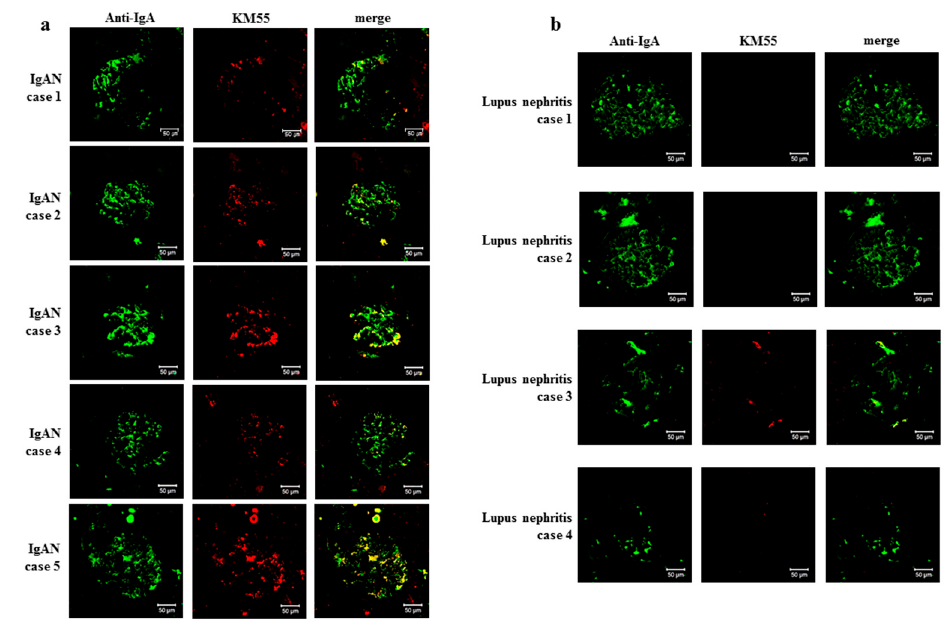
Figure 4. KM55 mAb staining. ( a ) KM55 mAb staining in IgA nephropathy. Glomerular galactose-deficient IgA1 staining was positive in cases of IgA nephropathy (IgAN). ( b ) KM55 mAb staining in lupus nephritis. Four cases of lupus nephritis are shown as examples. In all cases of lupus nephritis that were accompanied by glomerular IgA deposition, glomerular galactose-deficient IgA1 staining was negative (bars = 50 μ m; original magnification ×200).